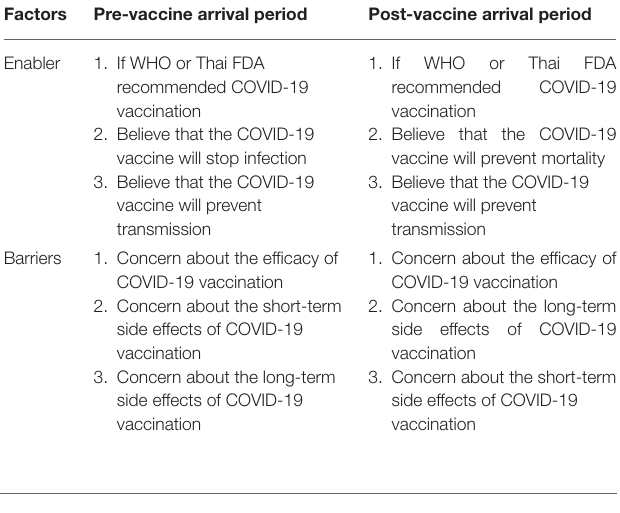
TABLE 2 | Perceived risk of COVID-19 by health care